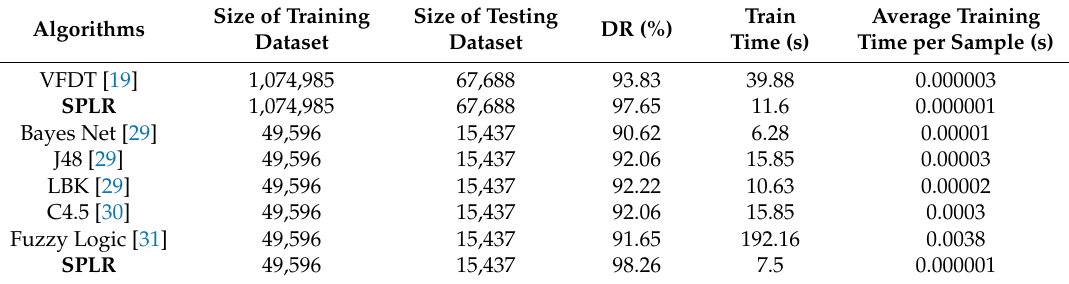
Table 5. Experimental performance comparison of SPLR with other classifier models.